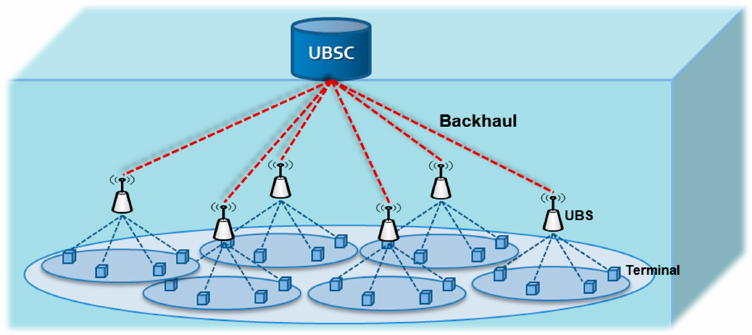
Figure 1. An underwater cellular wireless network consisting of UBS controller (UBSC), underwater base stations (UBSs) and underwater terminals (UTs).